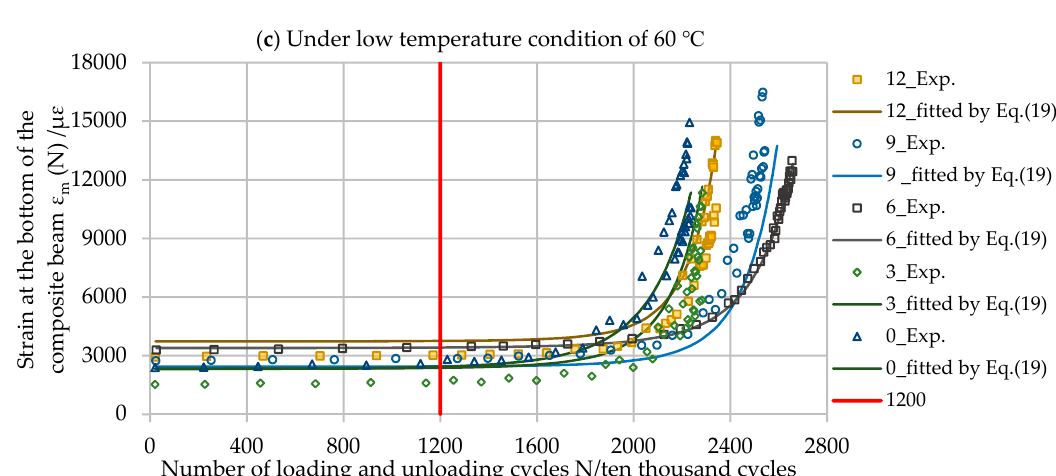
Figure 3. The relationships between the bottom edge strain ε cm ( N ) and fatigue load cycles N under di ff erent ambient temperatures and with fiber lengths of 3, 6, 9, and 12 mm: ( a ) under ambient temperature conditions, 60 ◦ C; ( b ) under normal temperature conditions, 20 ◦ C; ( c ) under ambient temperature conditions, − 15 ◦ C. Note: The red line denotes “1200 / 10,000 cycles,” which is the design standard for steel deck AC surfacing [47].